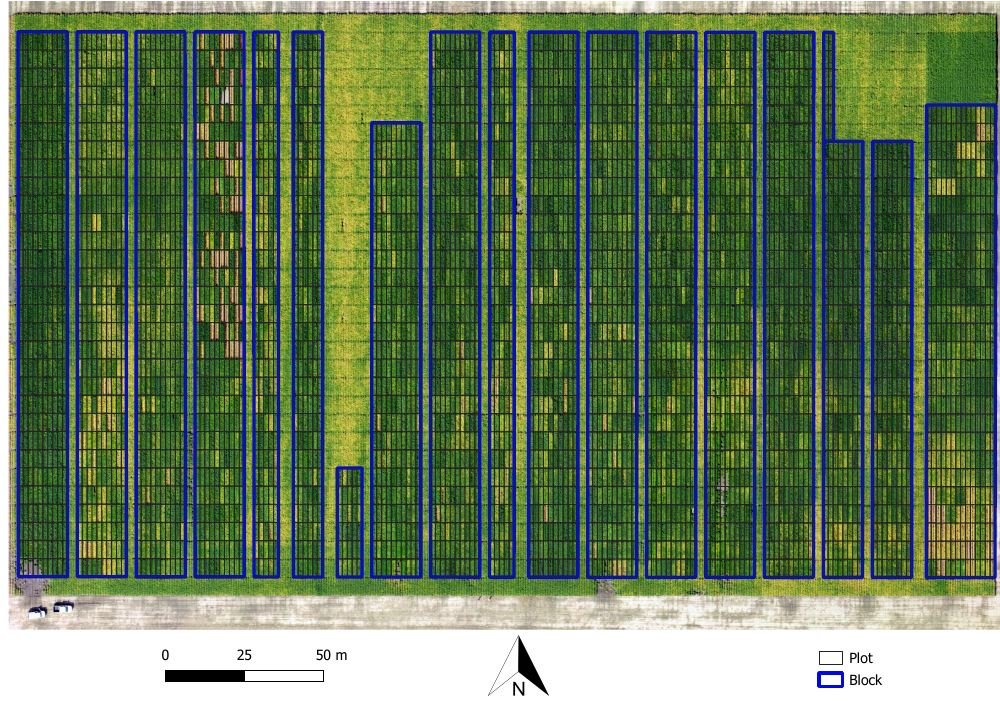
Figure 1. Example of soybean breeding field trial (T4) with layout of plots overlaid on top of the UAV mosaic from images acquired 112 days after